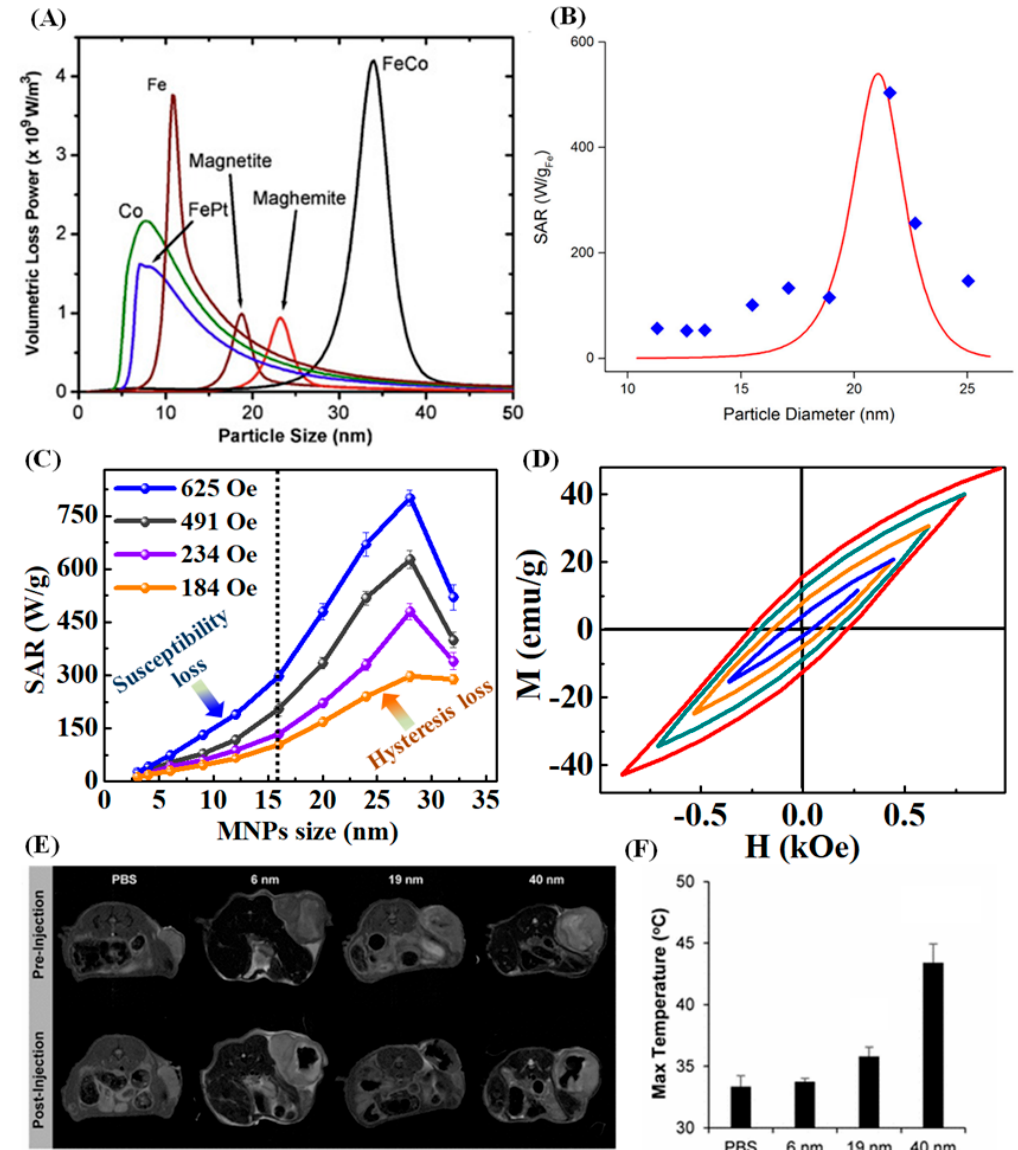
Figure 8. ( A ) Depicts volumetric loss power versus particle size for various MNPs dispersed in water at 10% particle concentration in ACMF ( f = 300 kHz, H ac = 50 mT) [80]. ( B ) The theoretical (red) and experimental (blue) SAR values of Fe 3 O 4 nanoparticles with di ff erent diameters [81]. ( C ) Depicts the variation of the SAR values as a function of MNP size at di ff erent amplitudes for the ACMF field (184–625 Oe) [71]. ( D ) Shows the room temperature minor M(H) loops of 28 nm MNPs at various magnetic fields: 300 (blue), 500 (orange), 700 (green) and 900 Oe (red) [71]. ( E ) MRI images of the cross section of the mouse bodies before and after infusion of 6, 19 and 40 nm Fe 3 O 4 nanoparticles dispersion and (F) Maximum temperature reached during 1 h of heating [76].